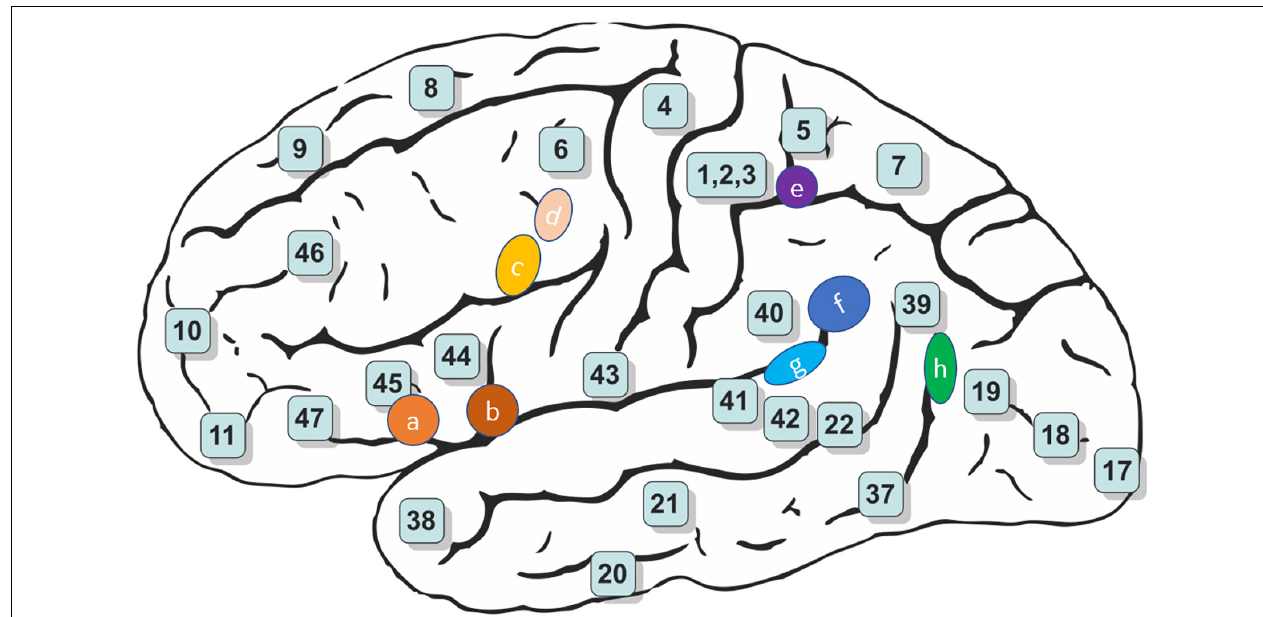
FIGURE 4 | Schematic brain representations illustrating the topography of the vestibular cortical fields experimentally identified in humans. The numbers indicate the architectonically defined BAs [based on Gray’s (1918) Anatomy of the Human Body]. The letters represent the vestibular sites with their localization in the cortical regions in the right panel (Ventre-Dominey,